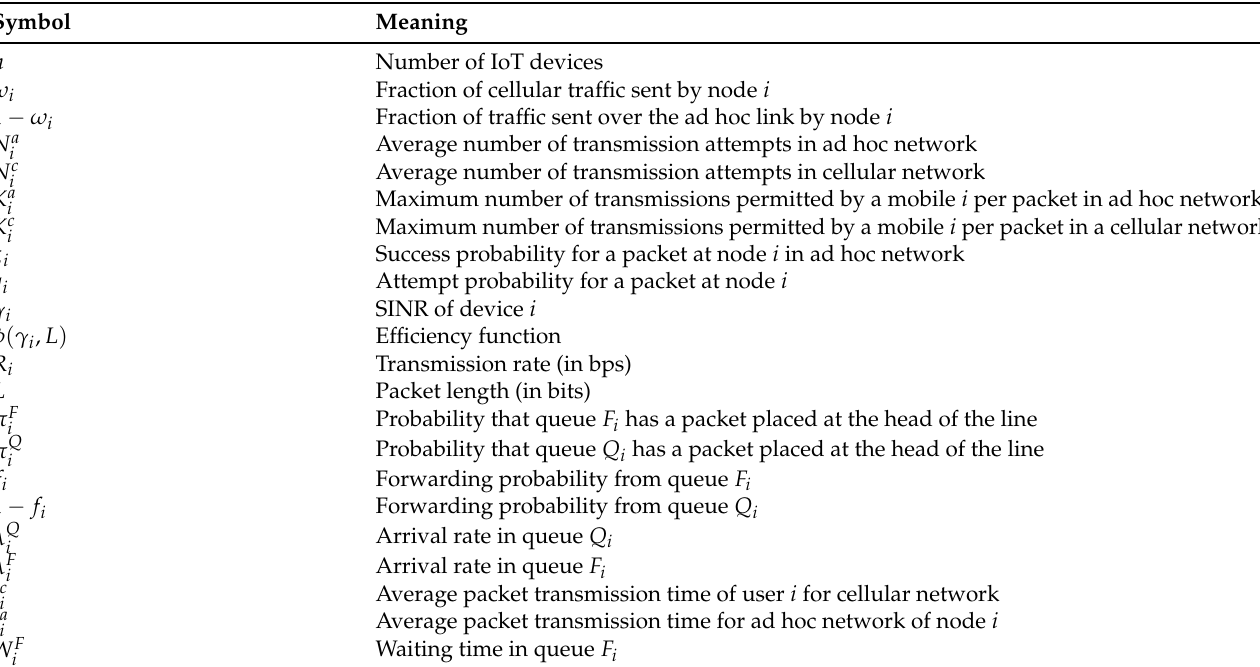
Table 2. Main symbols and their